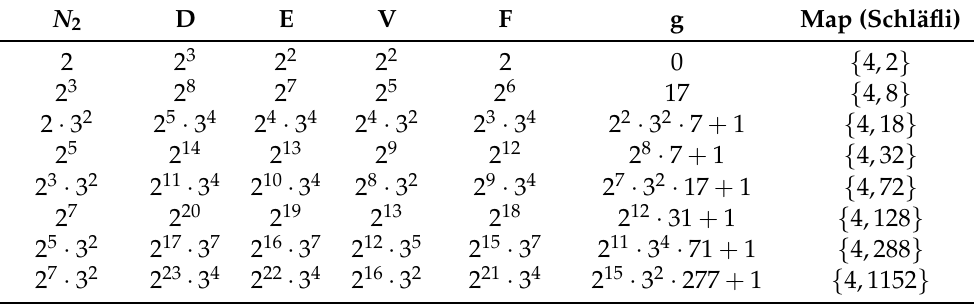
Table 2. The complete table of regular maps for N 2 .